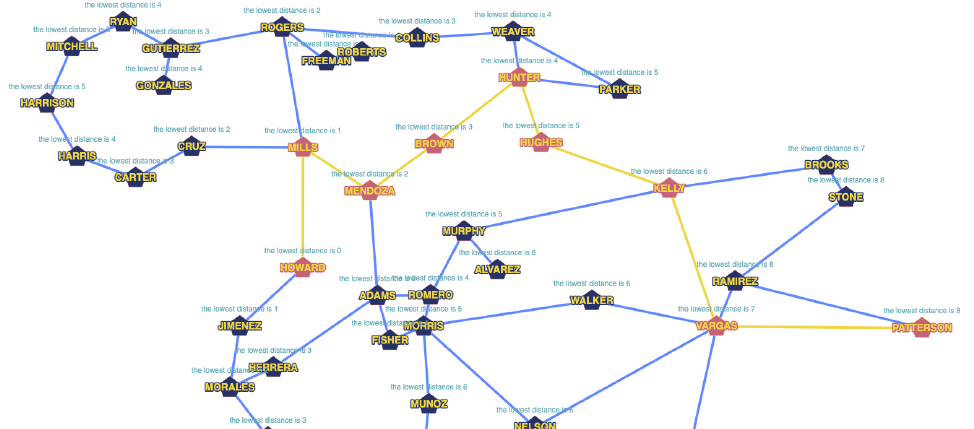
Figure 3. Detail of the optimal path between nodes Howard and Patterson at the initial moment of the simulation by applying Dijkstra’s